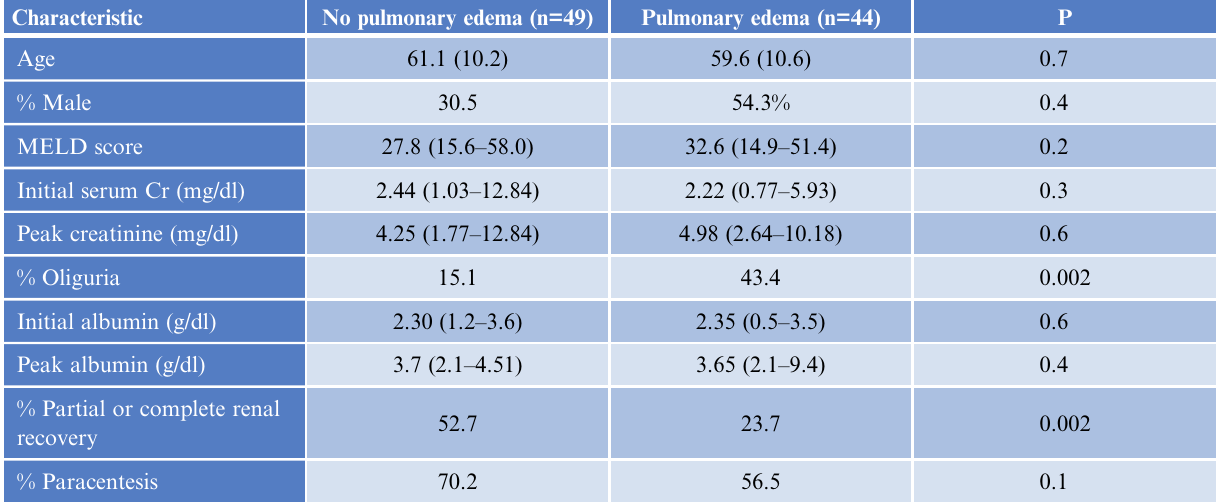
Table 2. Comparison of baseline characteristics of patients with hepatorenal disorders receiving intravenous albumin by the devel- opment of pulmonary edema (n=93) Characteristic